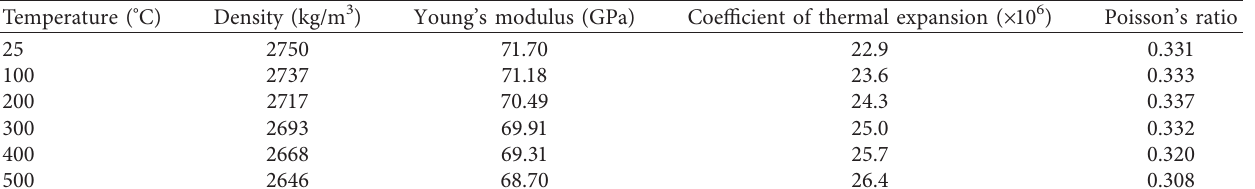
Table 1: Aluminum alloy material parameters with temperature variation.